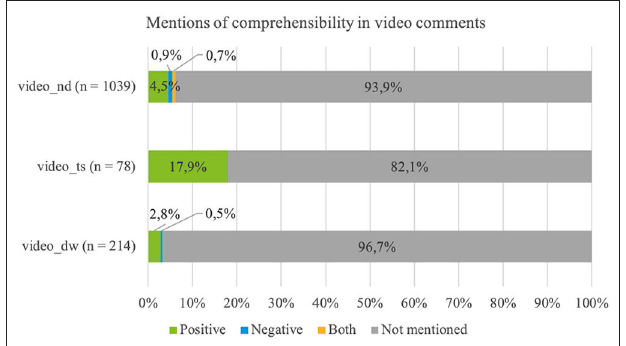
FIGURE 4 | Categorization of viewer’s comments on the three case study videos with respect to the presentation style.